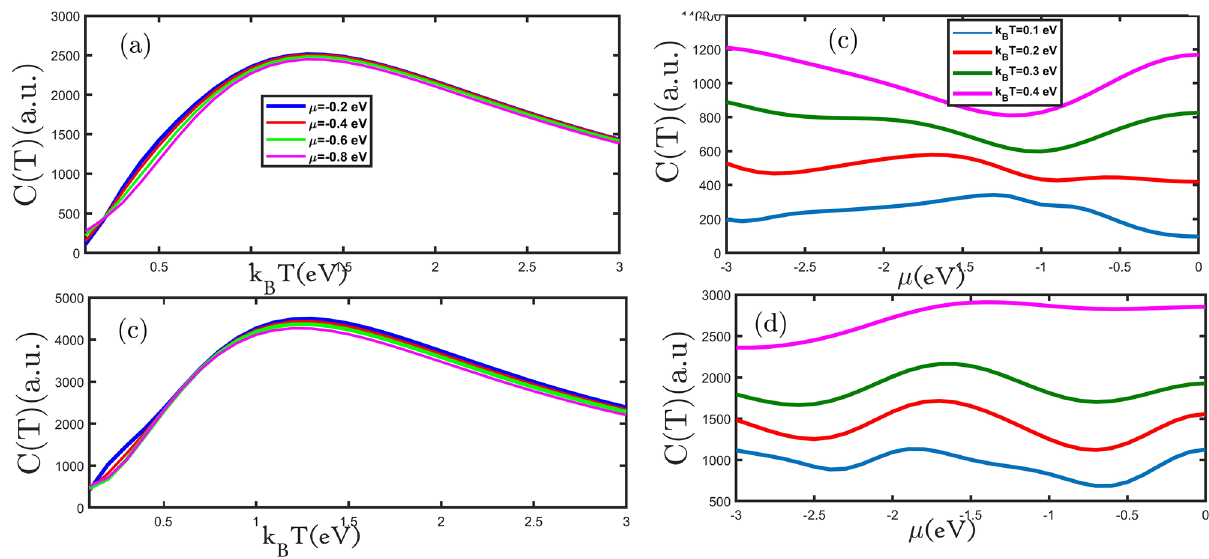
Figure 5. ( a – d ) the electronic heat capacity as a function of the temperature (hole doping) for the planar and buckled silicene monolayer in the presence of different hole doping (temperatures), respectively.